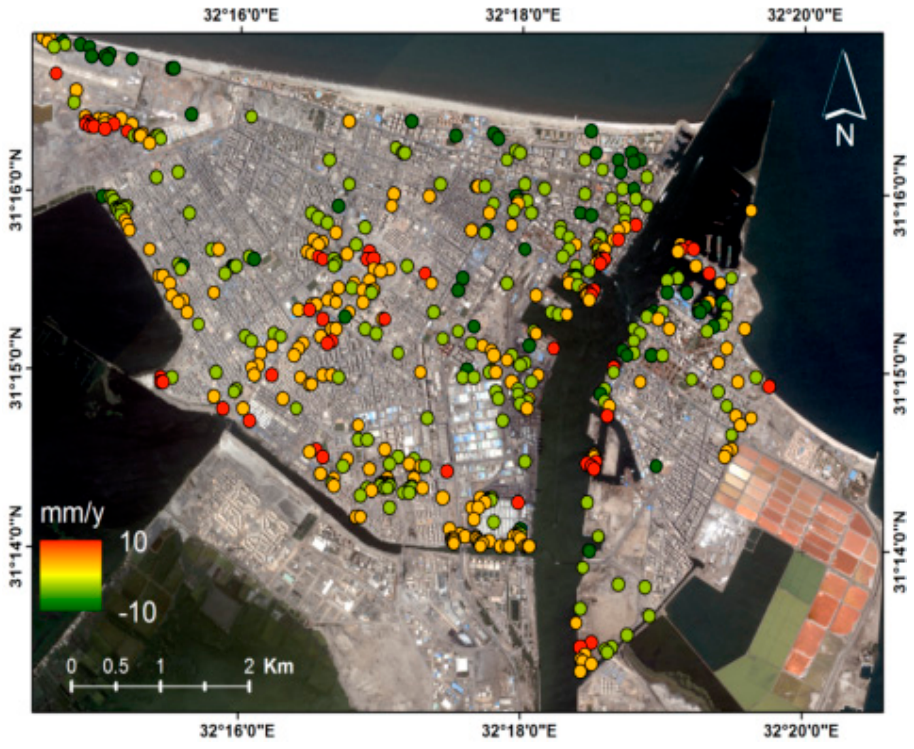
Figure 16. The average vertical ground motion velocities from 2007 to 2010 of pixels with coherence threshold ≥ 0.4.